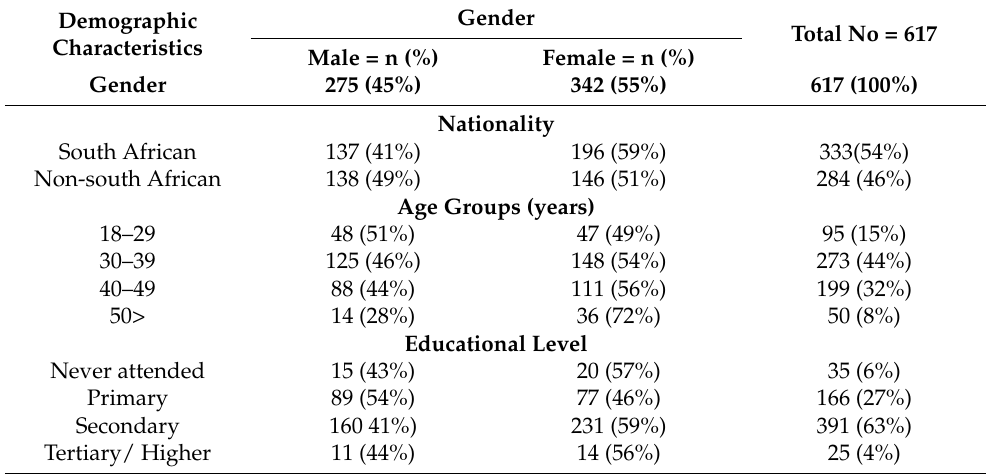
Table 1. Demographical characteristics of informal food vendors in the inner city of Johannesburg. Demographic